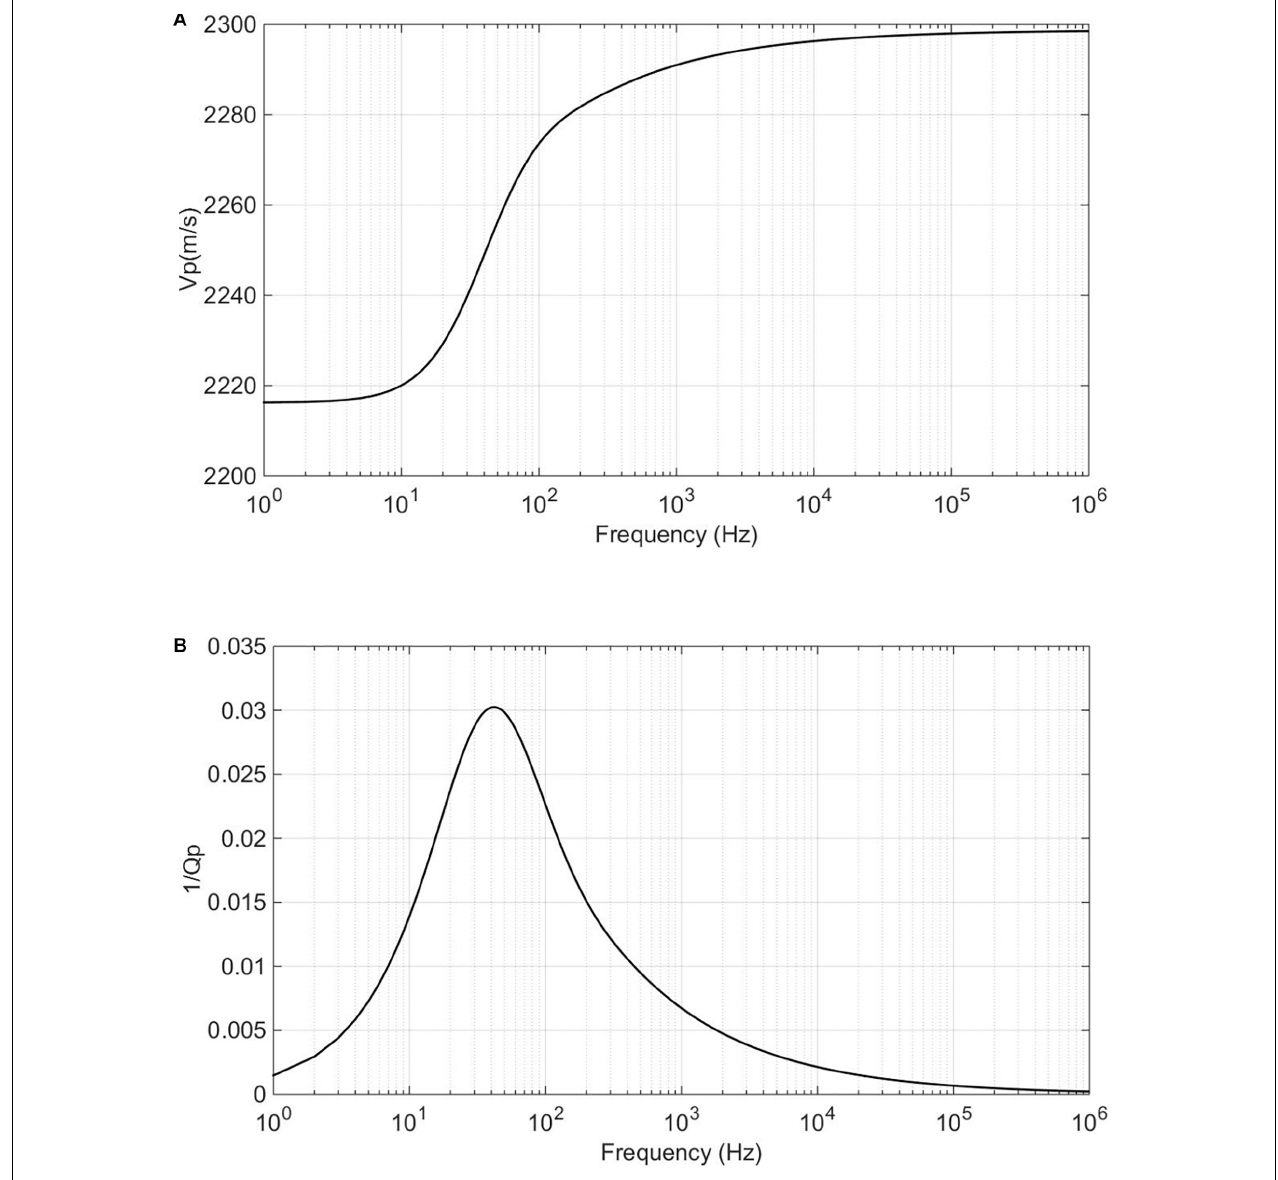
FIGURE 8 | (A) The P-wave velocity Vp dispersion and (B) attenuation factor 1/Qp for a free gas